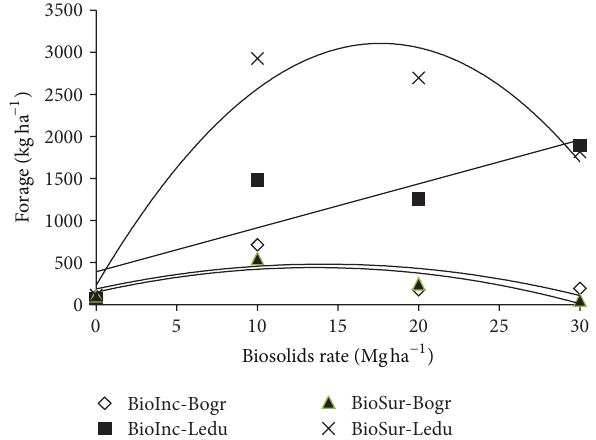
Figure 4: Forage production under different biosolids rates, meth- ods of application, and grass species at a seeded abandoned field in Chihuahua, Mexico. BioInc:soil-incorporated biosolids; Bio- Sur:surface-applied biosolids; Bogr: Bouteloua gracilis ; Ledu: Lepto- = 389.4 + 52.29𝑥 , 𝑃 = 0.0003 , 𝑟 2 = 0.74 , chloa dubia ; 𝑌 BioInc-Ledu = 229.95 + 325.99𝑥 − 9.23𝑥 2 , 𝑃 = 0.0001 , 𝑛 = 12 ; 𝑌 BioSur-Ledu = 185.65 + 41.86𝑥 − 1.48𝑥 2 , 𝑟 2 = 0.94 , 𝑛 = 12 ; 𝑌 BioInc-Bogr = 147.77+43.12𝑥−1.59𝑥 2 , 𝑃 = 0.0039 , 𝑟 2 = 0.39 , 𝑛 = 12 ; 𝑌 BioSur-Bogr 𝑃 = 0.0017 , 𝑟 2 = 0.75 , 𝑛 = 12